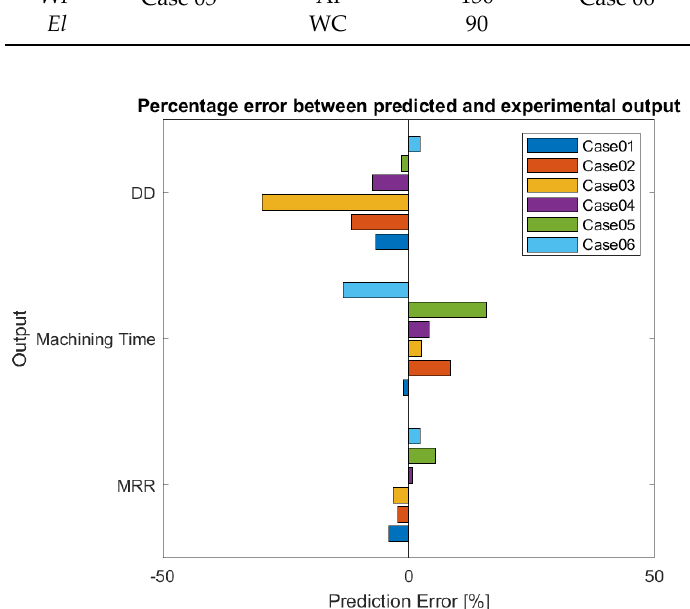
Figure 4. Percentage error between predicted and experimental process performances.